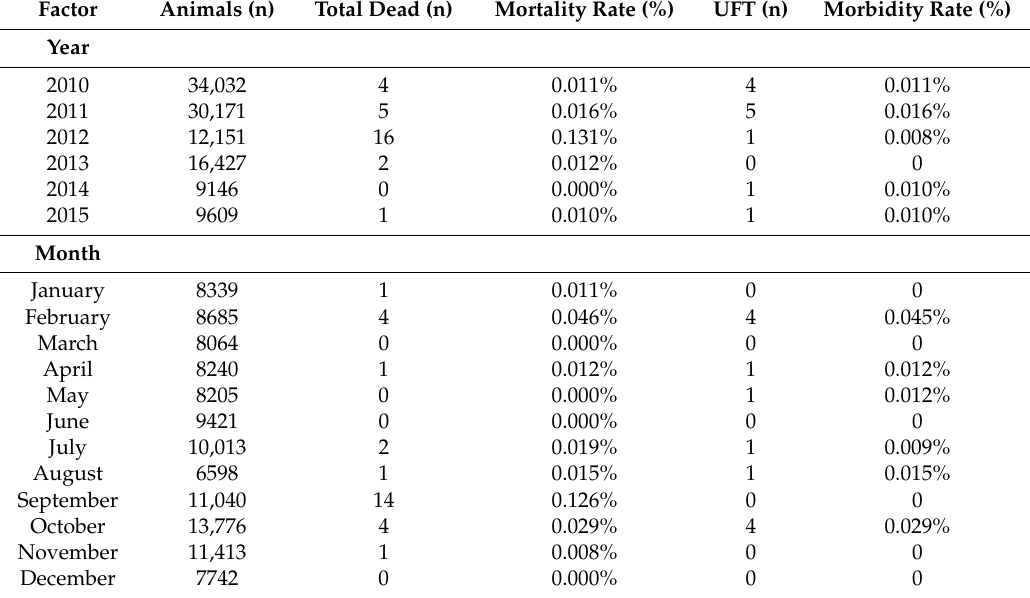
Table 3. Frequency table with overall calculated mortality and morbidity rates and calculated mortality and morbidity rates per year, month, season, species, and category. Total dead = dead on arrival (DOA) + dead at the control post